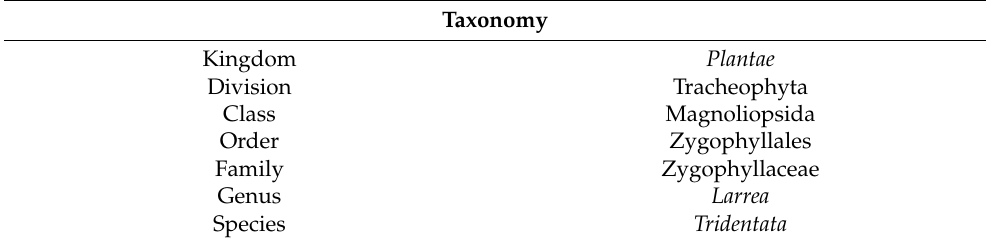
Table 1. Taxonomic classification of Larrea tridentata.